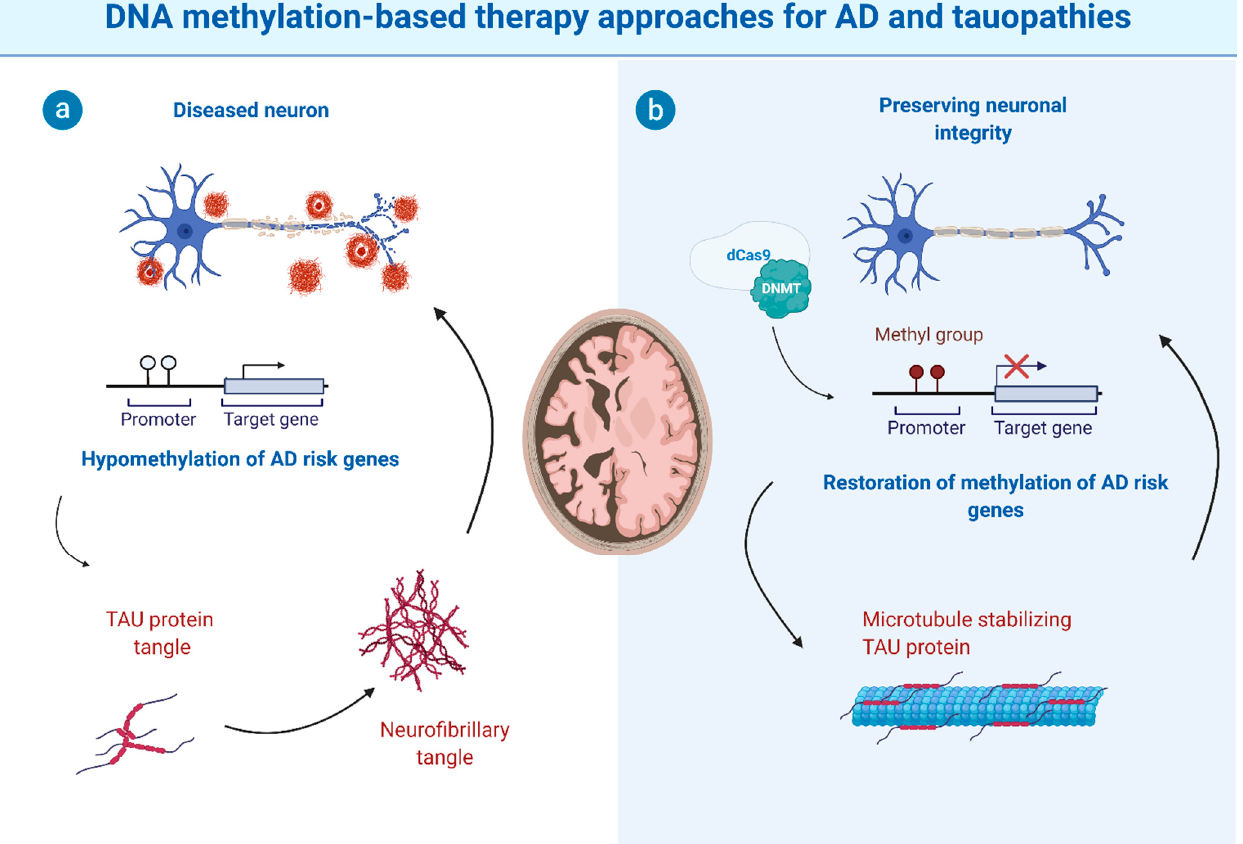
Figure 1. Putative potential of CRISPR/dCas9 editing-based therapeutic approaches for tauopathies that display impaired methylation patterns of selected genes/key regulator elements. ( a ) In disease paradigms, impaired DNA methylation (e.g., hypomethylation of risk genes associated with Alzheimer’s Disease (AD) and related/other tauopathies) results in increased TAU expression, decreased TAU clearance, or mislocalization, all of which lead to the accumulation of TAU and eventually to the formation of TAU protein aggregates. Neurons affected by this TAU pathology become dysfunctional and decay, eventually leading to impaired cognitive function and neurodegeneration. ( b ) CRISPR/dCas9 editing approaches may restore methylation patterns of AD and tauopathy risk genes, preventing abnormal production or modification of TAU protein and NFT formation, preserving the physiological function of TAU (i.a. microtubule stabilization) and preventing or partially reverse brain damage and disease progression. Possible genetic and non-genetic interventions could be (i) drug-induced modulation of methylation patterns, (ii) gene-replacement or RNAi-based gene therapy, or (iii) site/gene-specific modulation of methylation, e.g., as depicted, site-specific methylation via dCas9-directed DNMT targeting. This figure produced by using BioRender.com with a respective publication licence, provided by the Biology department of the RWTH Aachen University.